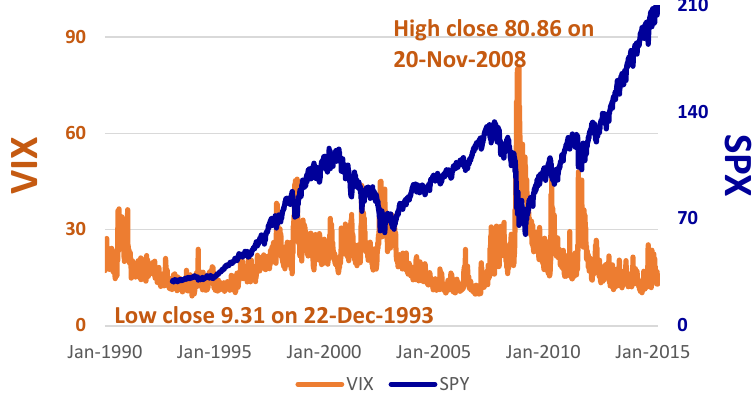
Figure 1. VIX and S&P 500 (SPX).